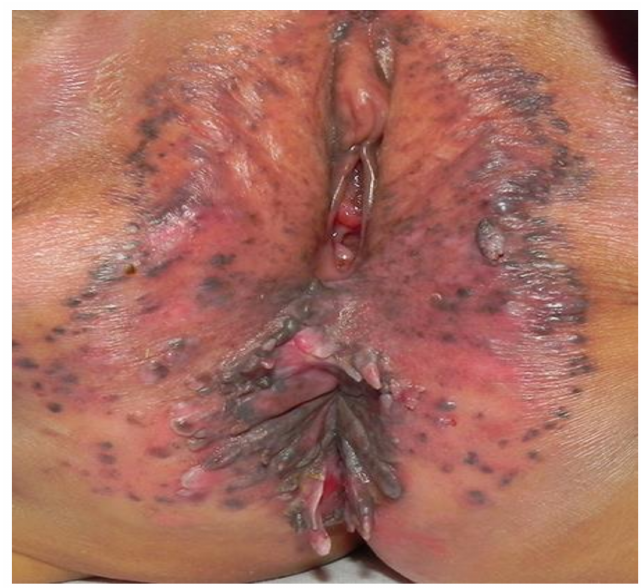
Figure 3. Anogenital warts (condyloma acuminata) (Patient